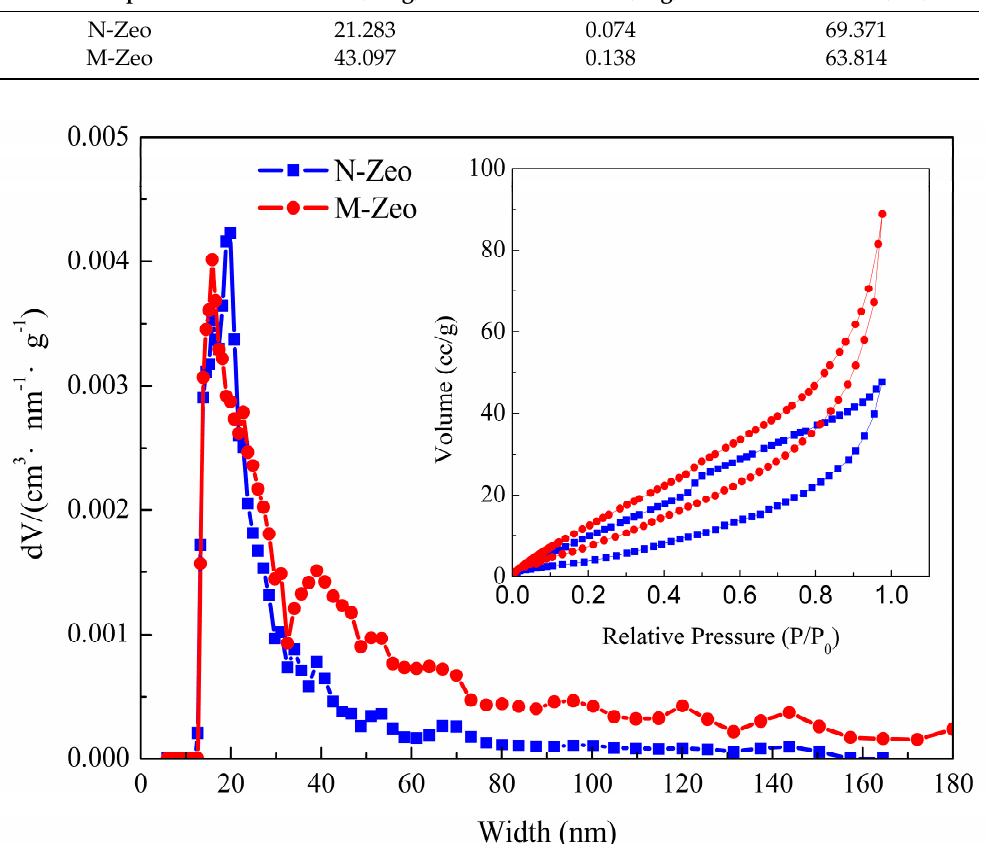
Figure 3. N 2 adsorption–desorption isotherms and pore size